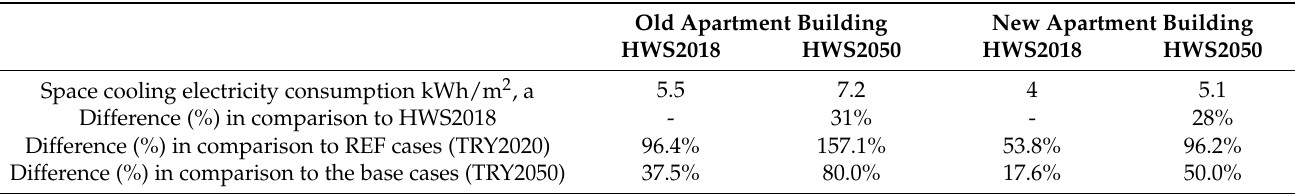
Table 7. The space cooling electricity consumption (kWh/m 2 a) of the cases with the split cooling unit in April–September 2018 (HWS2018) and its counterpart (HWS2050) in the projected climate around the year 2050.